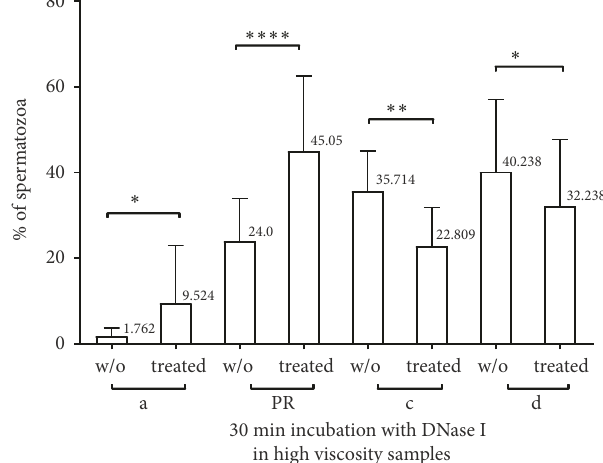
Figure 3: Effects of DNase I in motility of hyperviscous semen after 30 min incubation with DNase I. DNase I improves a movement in a statistical significant manner in hyperviscous semen but in a less spectacular way than fifteen min incubation. w/o: sperm without treatment, treated: sperm treated with DNase I, a: rapid progressive spermatozoa, c: non-progressive, d: immotile, and PR: motility of